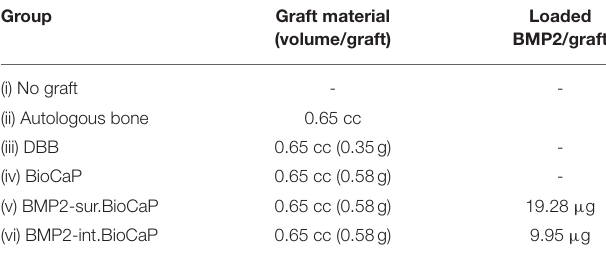
TABLE 1 | Graft materials implanted in different experimental